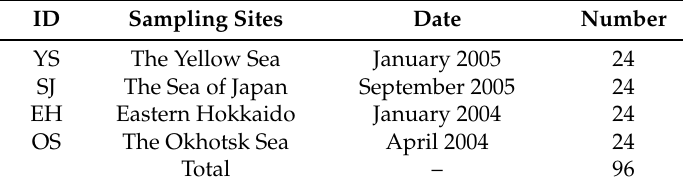
Table 6. Sampling sites, date of collection and sample size in the present study.